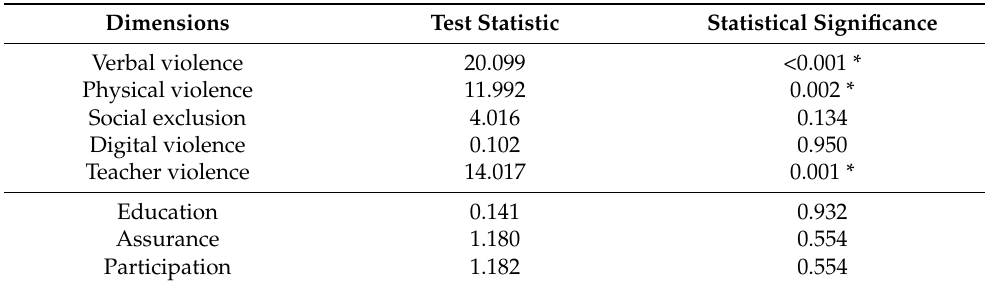
Table 12. Kruskal–Wallis test, ancestry category. Source: prepared by the authors. Dimensions Test Statistic Statistical Significance Verbal violence